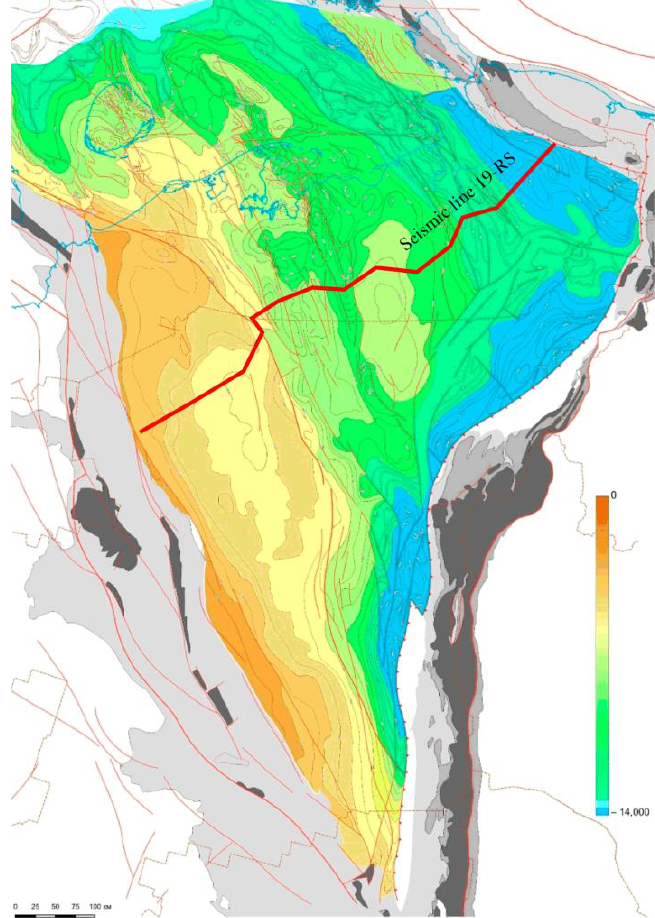
Figure 9. Structural map of the top of basement (RH VI).